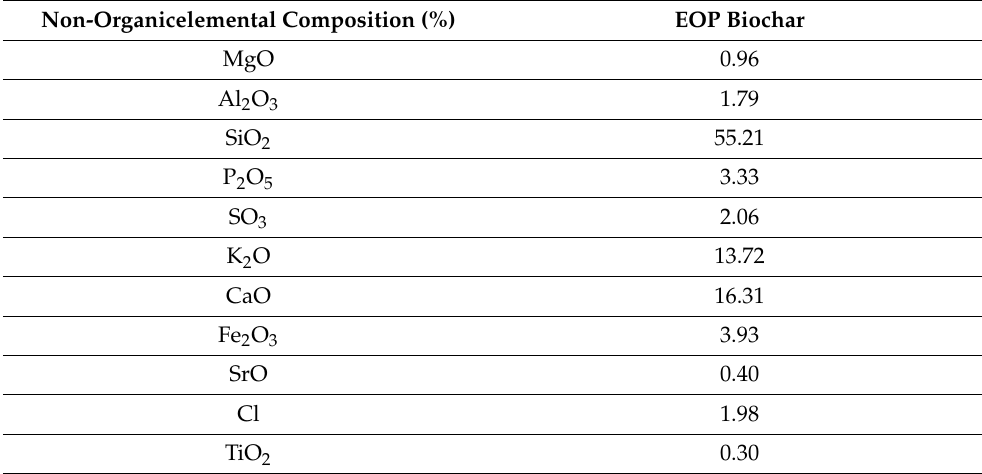
Table 2. Mineral composition of the EOP biochar ashes obtained using XRF analysis. Non-Organicelemental Composition (%)